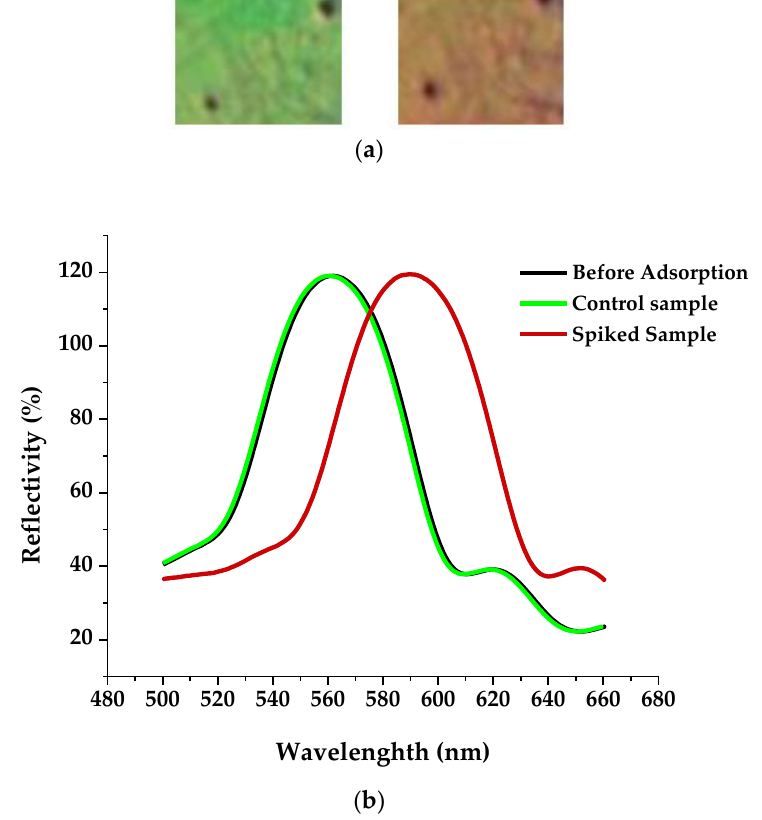
Figure 7. ( a )The color of MIPC in the control sample solution ( left, green ) and the spiked sample solution ( right, orange ); ( b ) The Bragg diffraction spectra of MIPC in different sample solution .